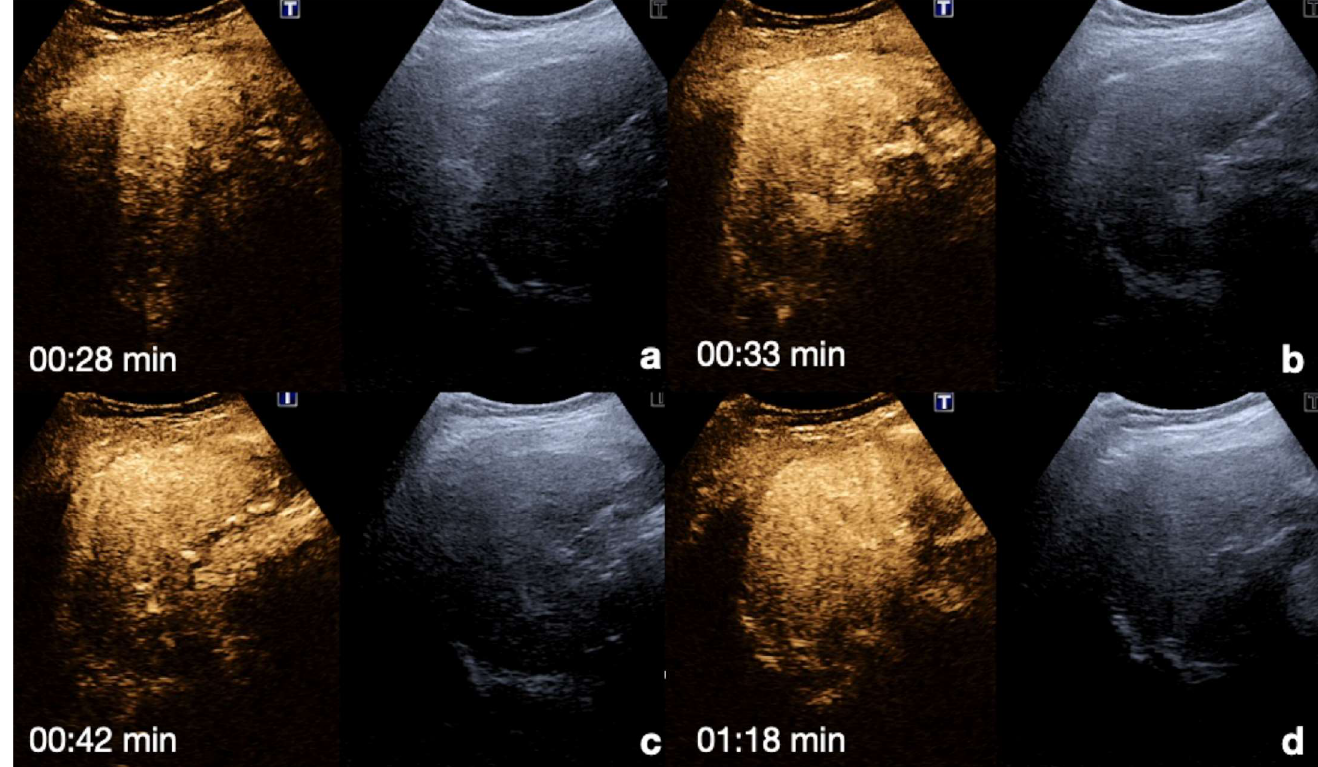
Figure 7. CEUS findings in a normal spleen ( a – d ). Note the progressive physiological